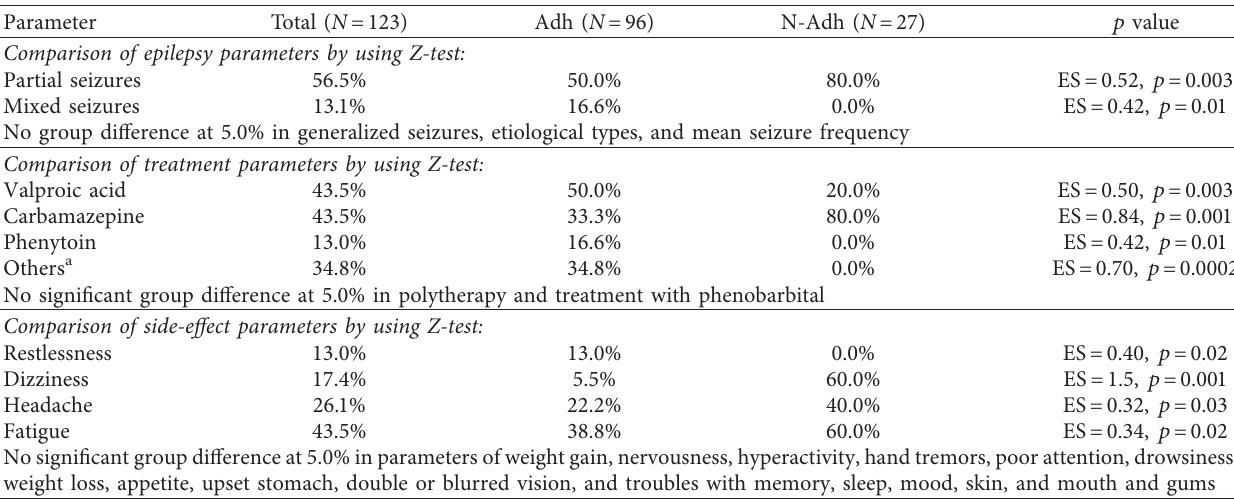
Table 2: Clinical variables related to epilepsy among participants assessed for medication beliefs and adherence to antiseizure